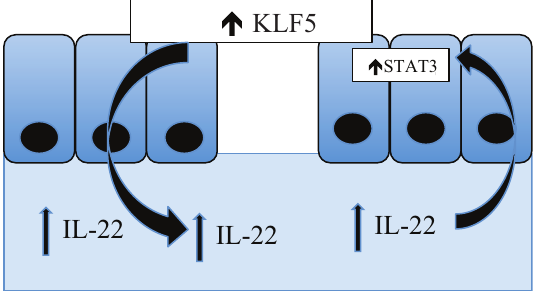
Figure 6. Model for the protective role of KLF5 in intestinal wound healing during colitis. KLF5 induces the expression of specific cytokines by epithelial cells, leading to the recruitment of immune cells and elaboration of IL22, which then activates STAT3 signaling within the colonic epithelial cells.